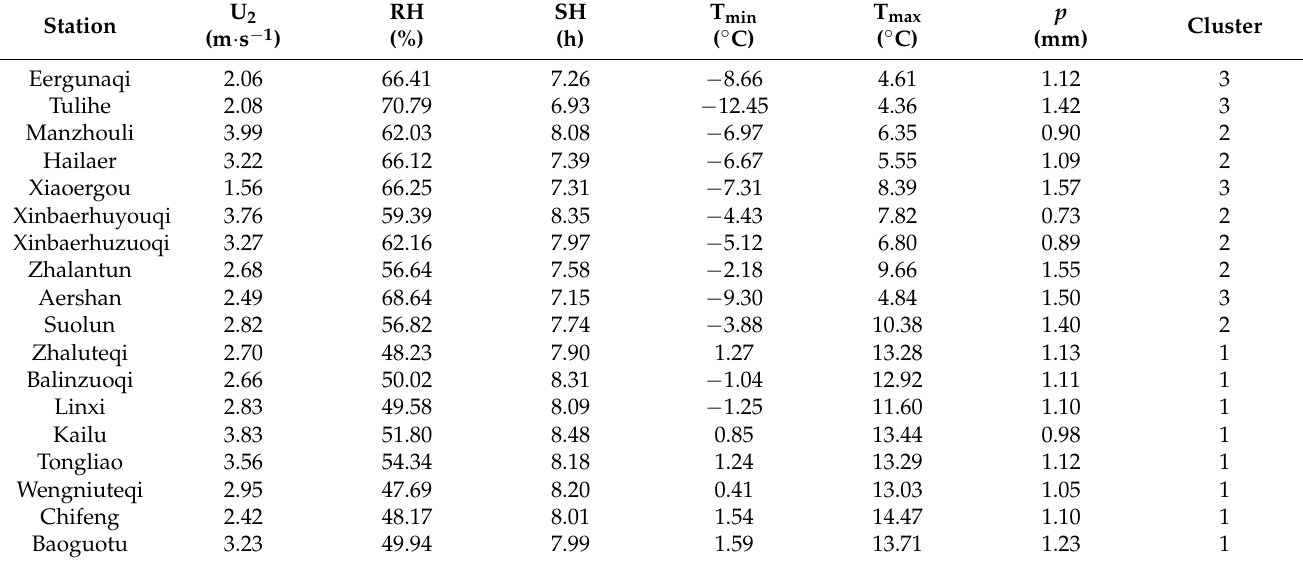
Table 1. Geographic and meteorological information of the 18 weather stations and the cluster number of weather stations during the period